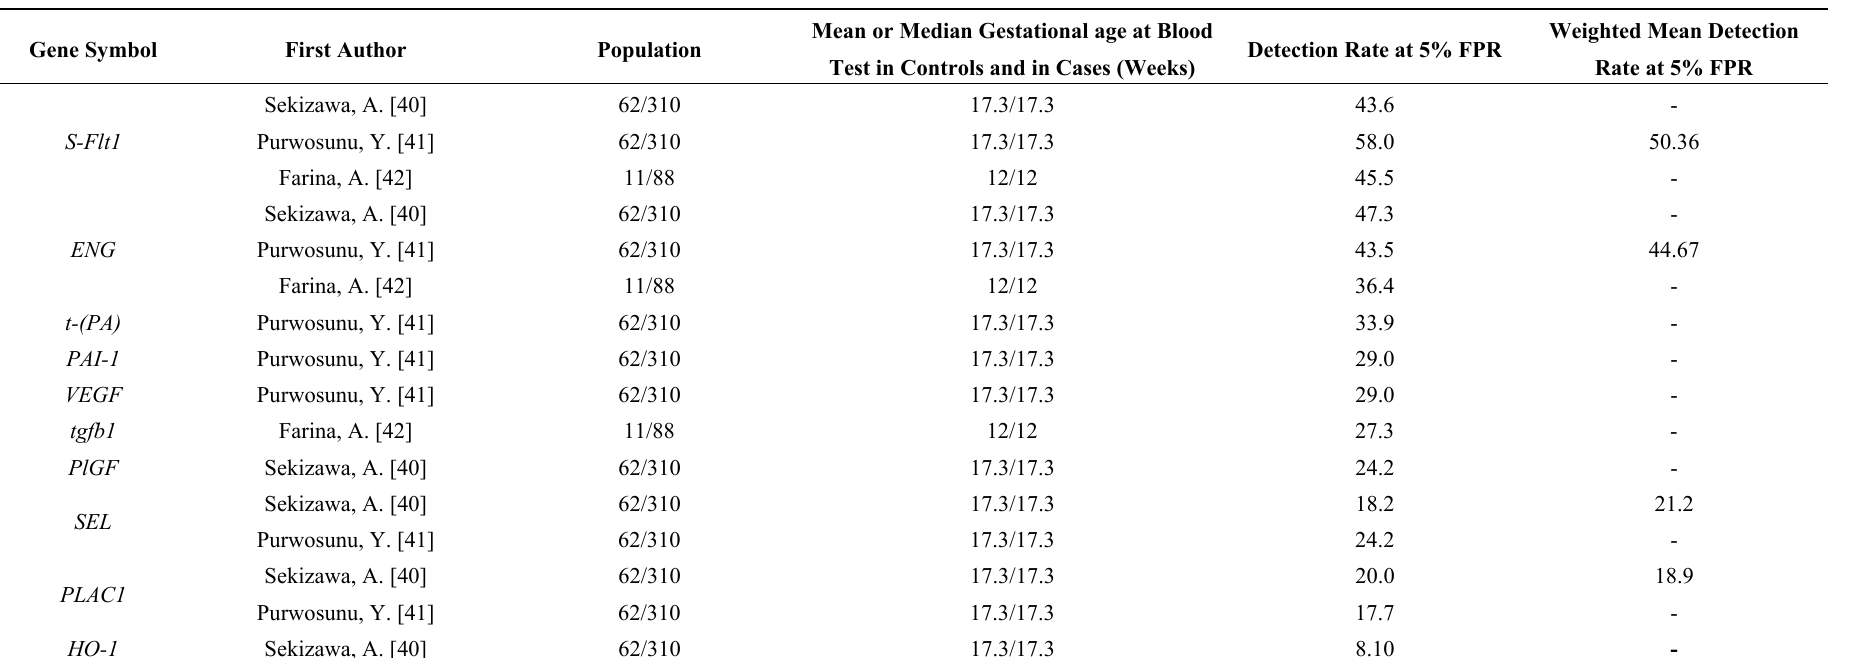
Table 2. mRNA species dosed in maternal plasma or whole blood variably distributed in patients who developed PE later in pregnancy. Gene